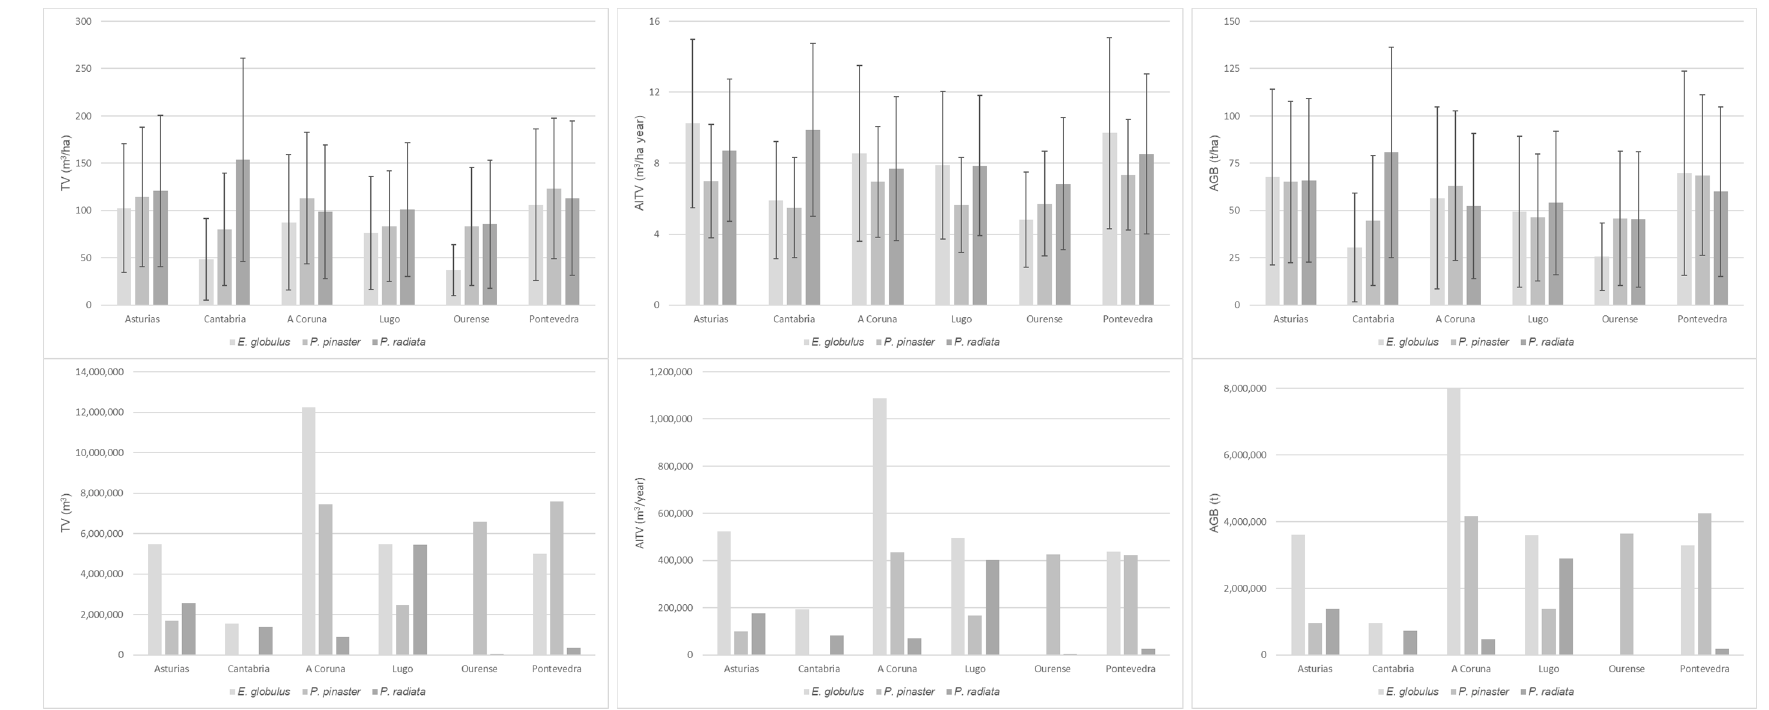
Figure 6. Graphs showing the average and standard deviation (error bars) values per hectare (top) and total (bottom) of the ALS-based wall-to-wall predictions per province for total volume (TV), annual increase in total volume (AITV) and total aboveground biomass (AGB), for the three forest species studied. Results were obtained by applying the best model obtained in this study and the species distribution provided by the Spanish Forest Map.